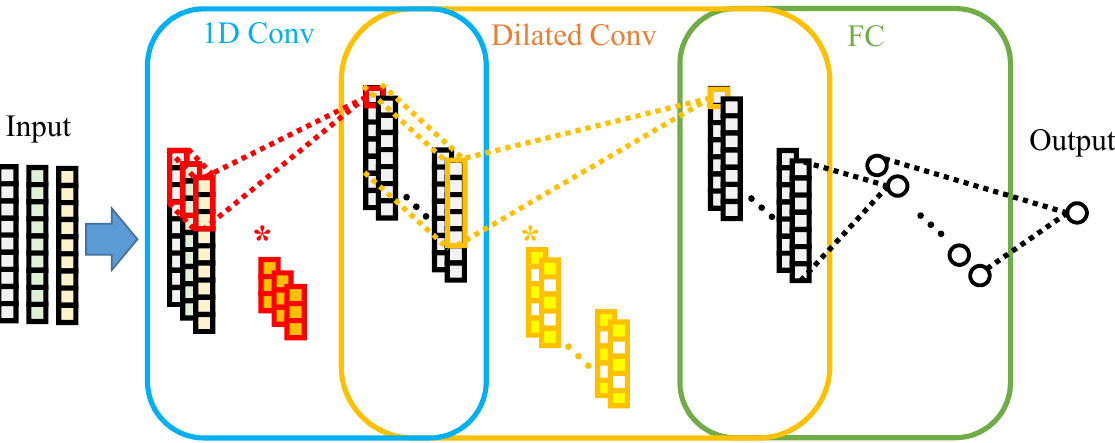
Figure 5. Overall structure of battery SOH prediction model based on Dilated CNN.